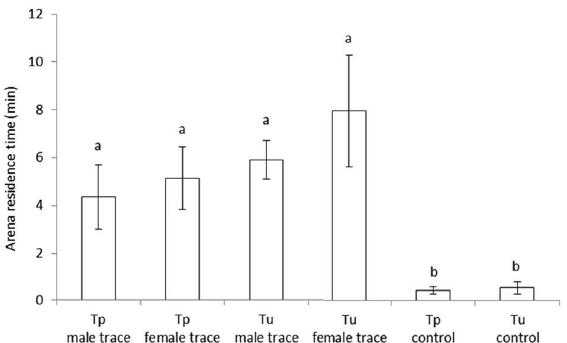
Figure 1 - Arena residence time (average time spent by wasps in the entire arena) when exploiting traces from Piezodorus guildinii female or male, or no stink bug traces (control). Diff erent letters indicate signifi cant diff erences. Bars denote 95% confi dence intervals. Tp: Telenomus podisi ; Tu: Trissolcus urichi less time in control treatment than in male or